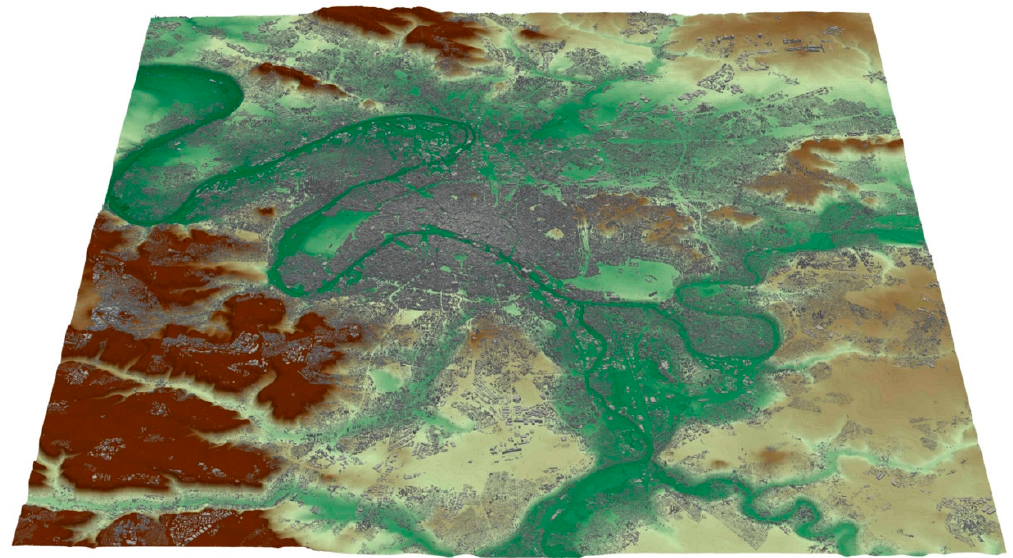
Figure 3. 3D view of the topography and buildings.